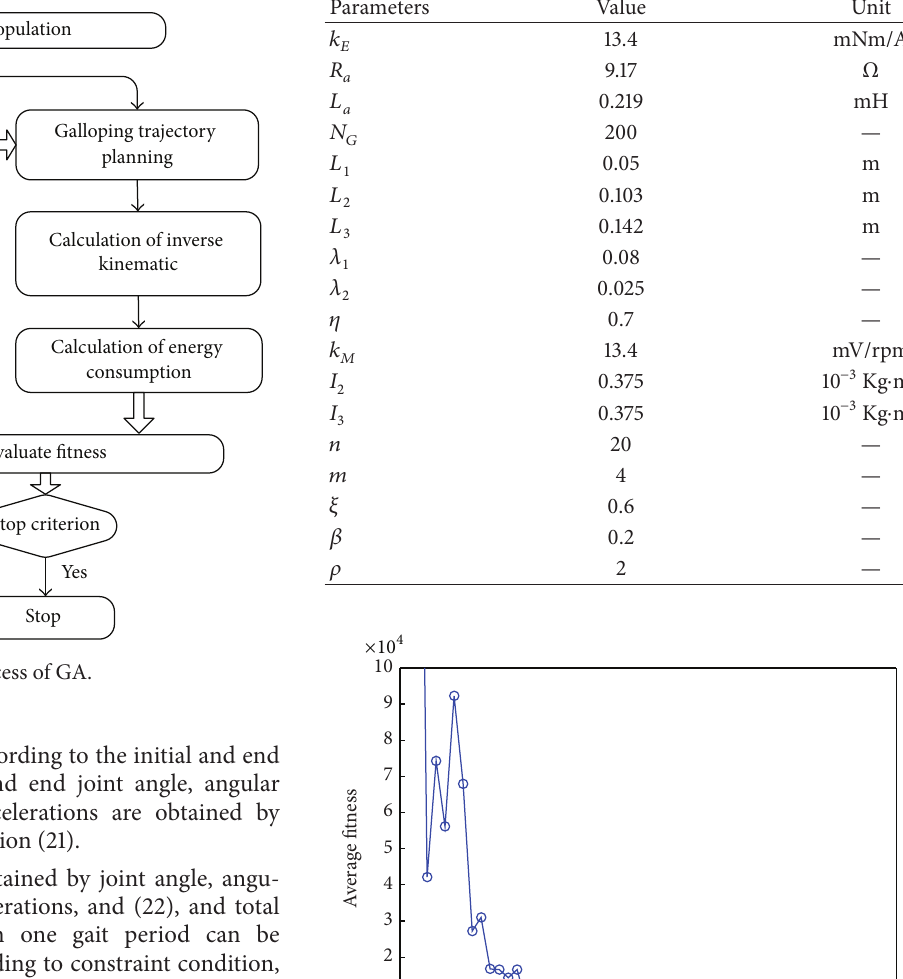
Table 1: Parameters of system.